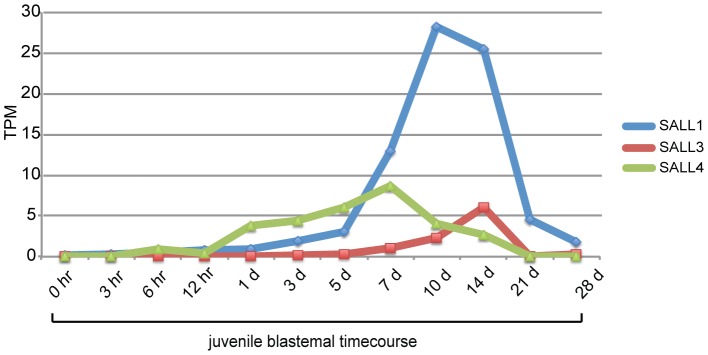
Expression of SALL1, SALL3, and SALL4 in juvenile blastemas.
SALL4 is upregulated earlier than SALL1 or SALL3. “TPM” is the Transcripts Per Million expression measure.